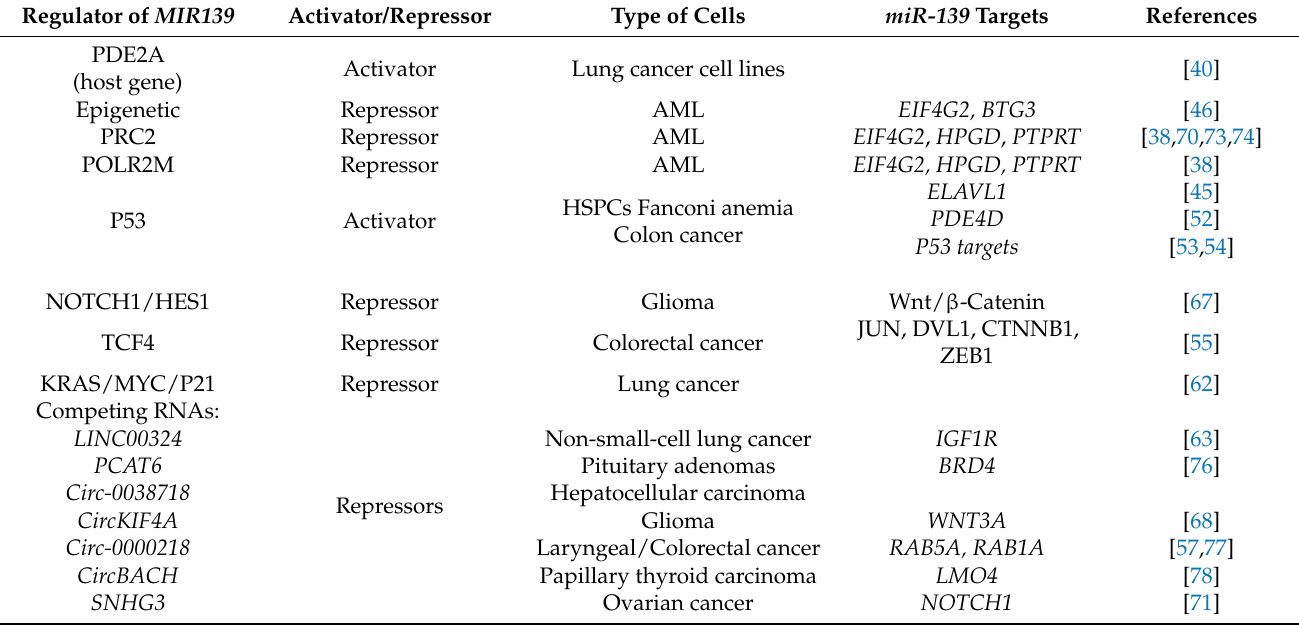
Table 2. Overview of Activators and Repressors of MIR139